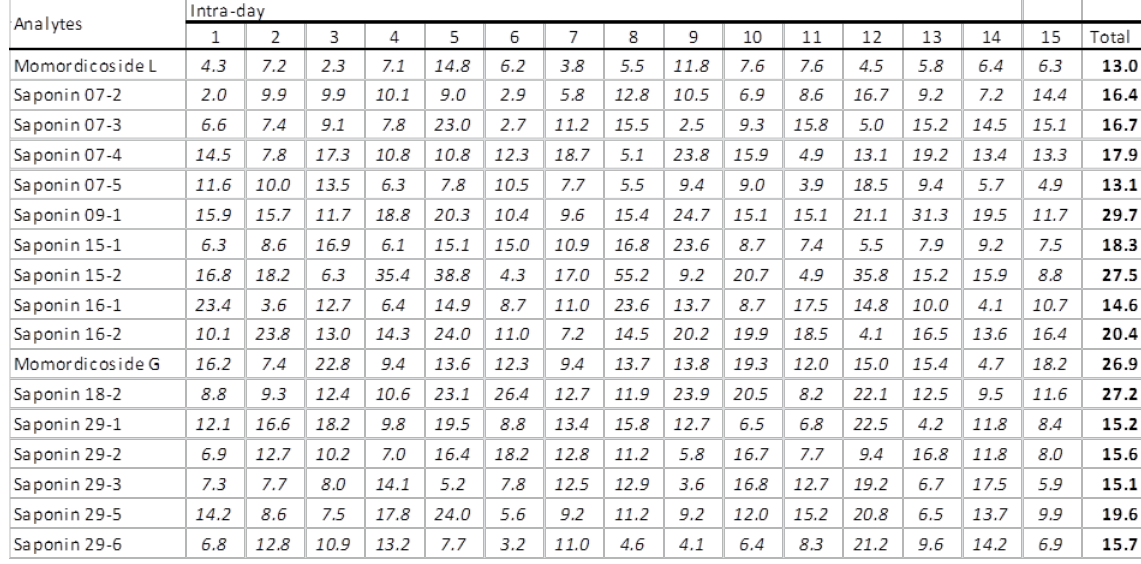
Table S2: Intra-day (n = 4) and total (n = 60) repeatability as CV values of saponin compounds in QC samples before signal intensity drift/batch correction.